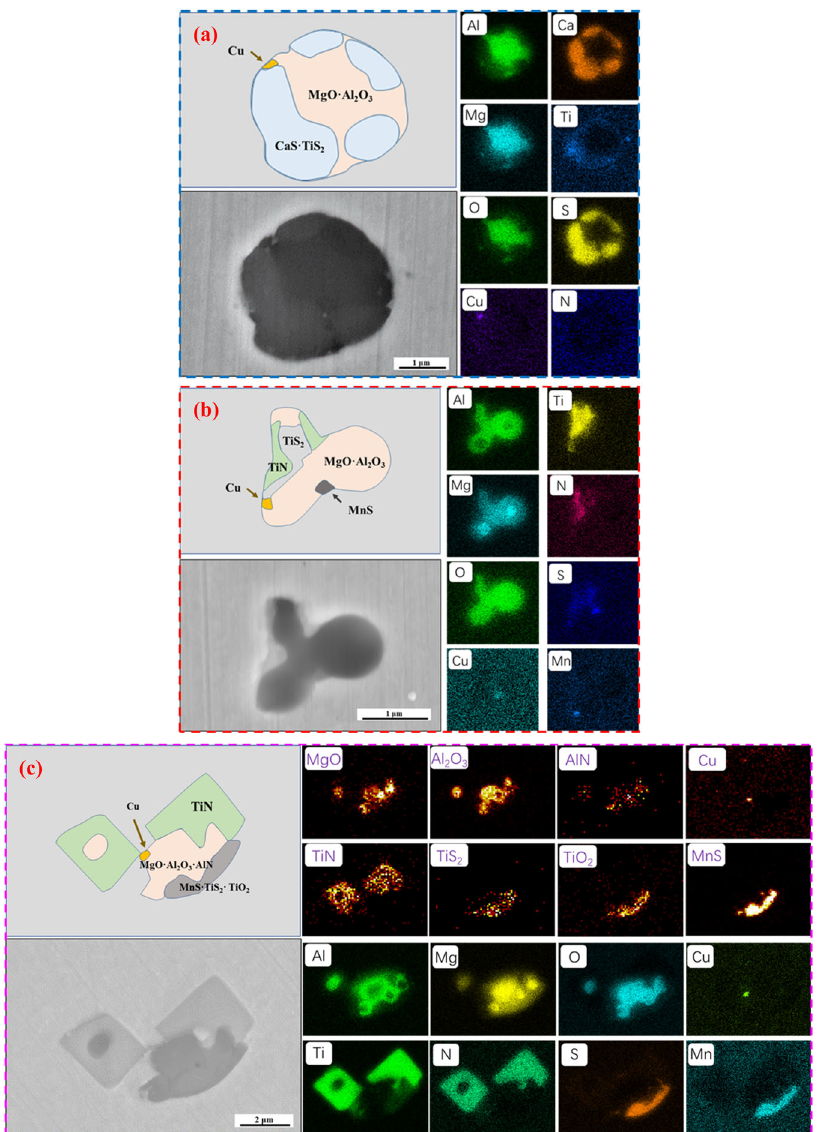
Fig. 9 Various inclusions containing Cu precipitates. a The precipitation behaviors of Cu at the CaS/CaO – MgO – Al 2 O 3 inclusion. b The precipitation behaviors of Cu at the TiN – TiS 2 – MnS – MgO – Al 2 O 3 inclusion. c Cu exists as a precipitated phase at the boundary of the compound The microstructure and morphology of the matrix were characterized by a JEM-F200 fi eld emission transmission electron microscope (FE-TEM). The selected region was analyzed by selected area electron diffraction (SAED), and the element distributions in the grain boundary and intragrain region were analyzed by energy dispersive spectrometry (EDS). The TEM samples were prepared by electrolytic double-spray technique with the solution of 90 vol% acetic acid and 10 vol% perchloric acid. The working voltage was 20 V and the temperature was 243 K. The inclusions containing Cu on the surface of the material were observed by a GEMINISEM500 fi eld emission scanning electron microscope (FE-SEM), and the element distribution of the inclusion was analyzed by energy-dispersive spectrometry (EDS). The micro- scope Vickers hardness tester was used to locate the target inclusions. The Cu-containing inclusions were cut by a focused ion beam (FIB), the distributions of elements at the boundary of Cu- containing inclusions were analyzed by CAMECA three-dimensional atomic probes (3DAP); the segregation distribution characteristics of